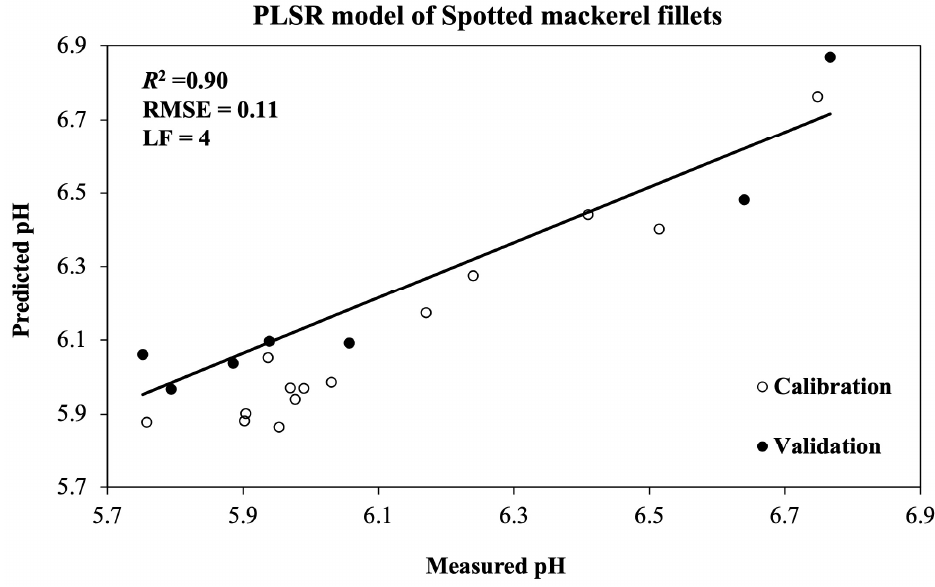
Figure 6. PLSR model for pH prediction in frozen spotted mackerel fillets previously stored in ice for 0–40